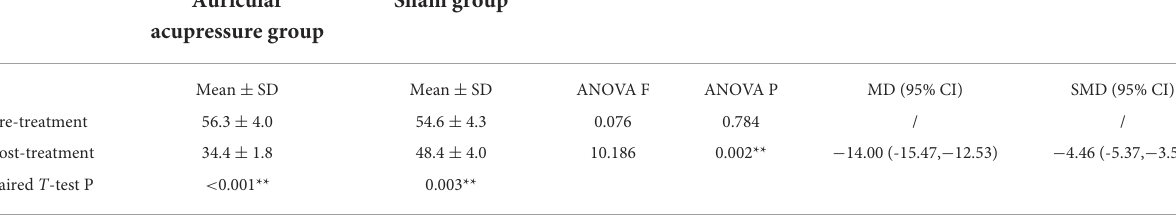
TABLE 3 Results of SAS in auricular acupressure and sham